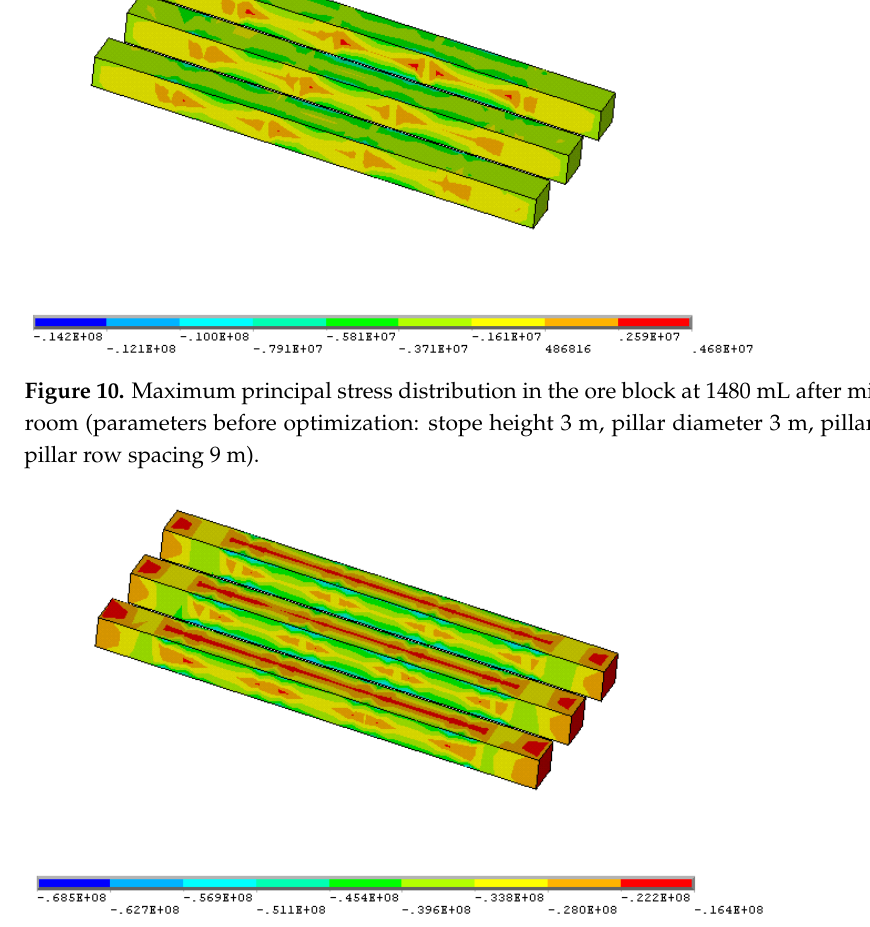
Figure 11. Minimum principal stress distribution in the ore block at 1480 mL after mining the strip room (parameters before optimization: stope height 3 m, pillar diameter 3 m, pillar spacing 7 m, pillar row spacing 9 m).